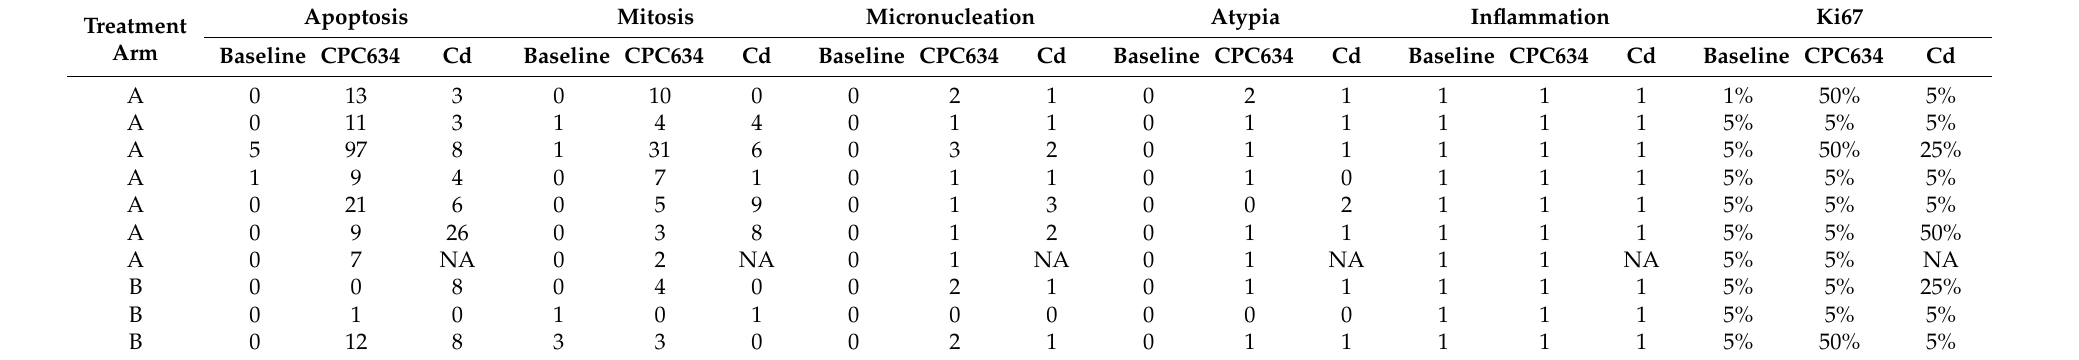
Table 3. Semi-quantitative histopathological analysis of the skin biopsies (0 absent; 1 mild, 2 moderate, 3